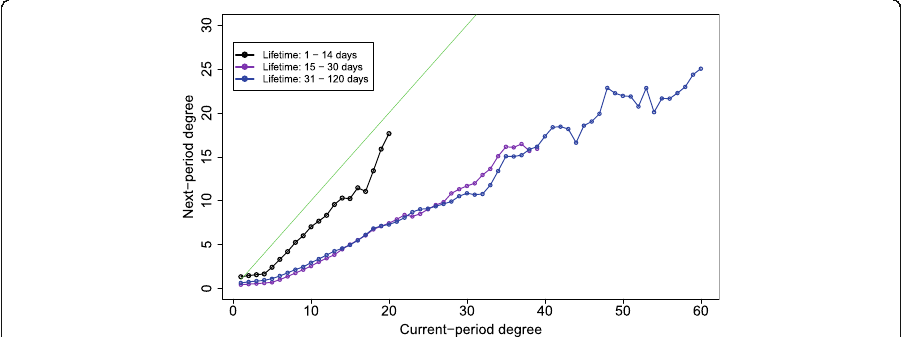
Fig. 4. The stability reference line is in